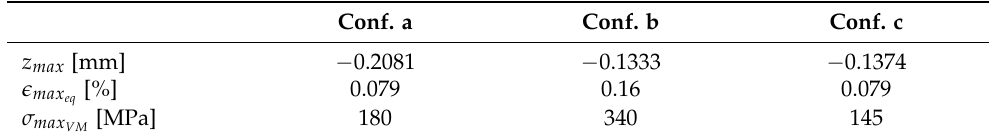
Table 3. Maximum values of deflection ( z max ), equivalent strain ( (cid:101) max for the three configurations.